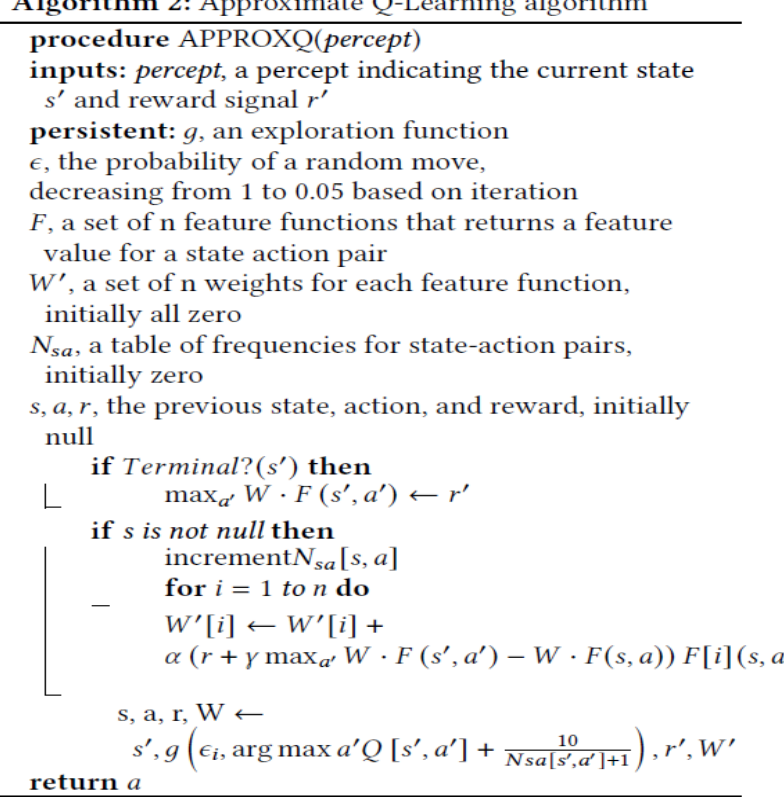
Figure 8. The algorithm used for approx